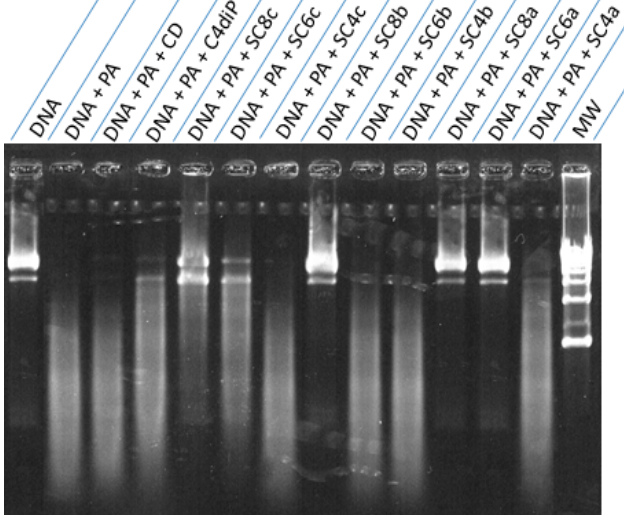
Figure 2. Agarose gel electrophoresis showing the inhibition activity of different macrocyclic molecules at 100 μ M on the digestion of DNA-Lambda phage by PA endonuclease protein. Molecular weight (MW) ladder (kb) is shown on the right.